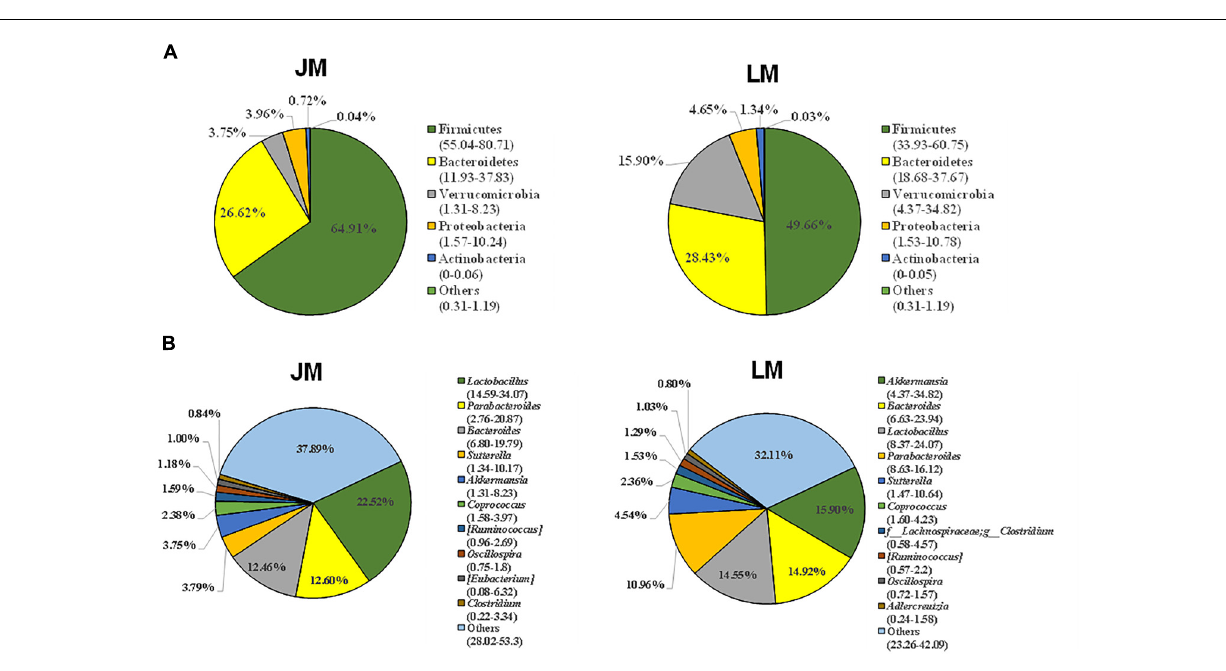
tissue of Jinhua pigs were also higher than those in Landrace